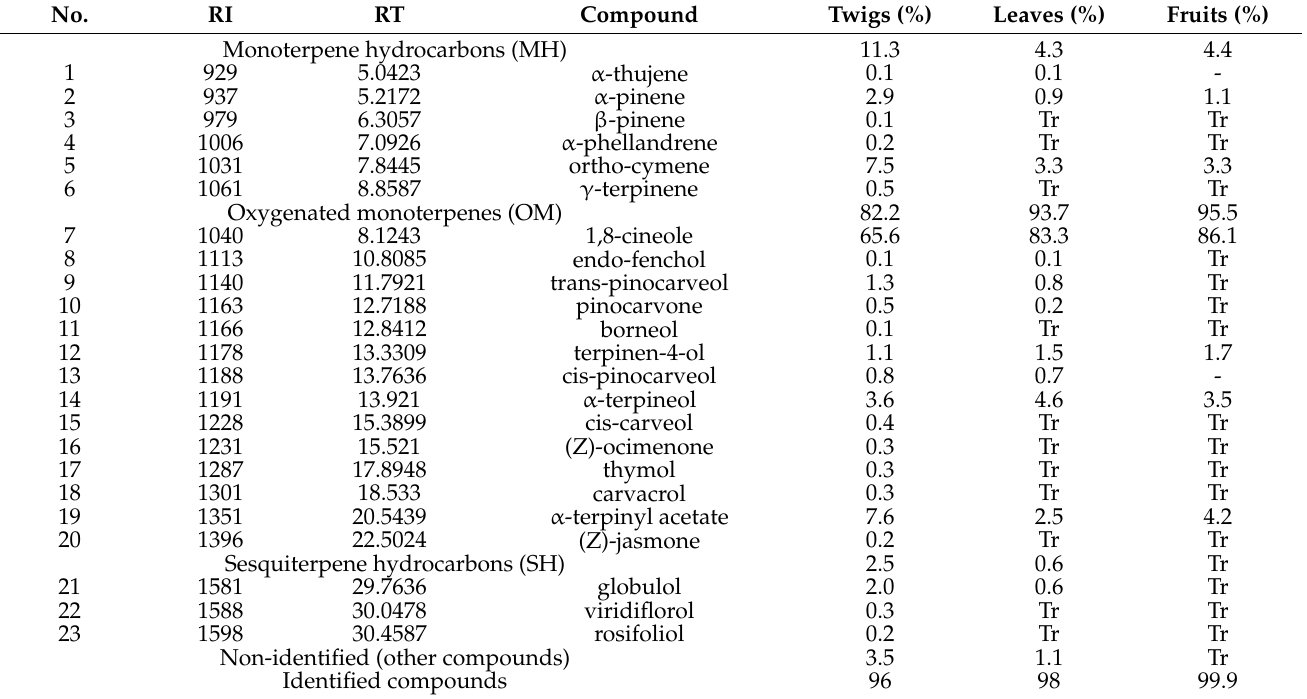
Table 1. Compositions of the essential oils obtained from twigs, leaves, and fruits of Eucalyptus. gunnii collected in Northern